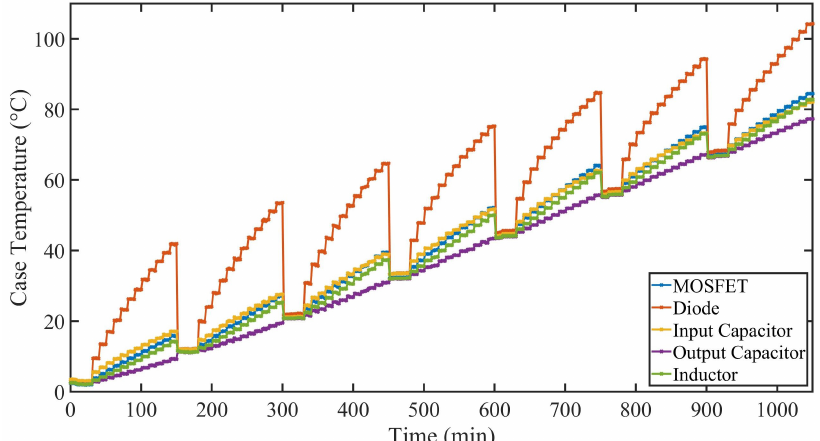
Figure 8. Average measured component case temperatures ( ◦ C) of the three-leg interleaved boost converter resulting from the input profile shown in Figure